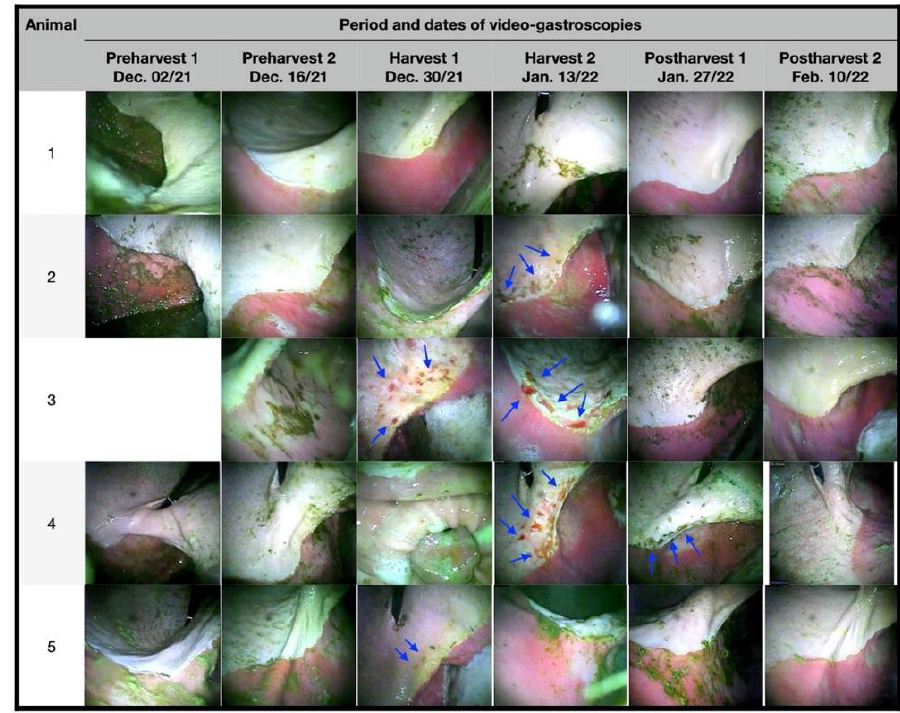
Figure 1. Photographs of video gastroscopies of experimental animals preharvest (1 and 2), harvest (1 and 2), and postharvest (1 and 2) in the region of the lesser curvature, close to the antrum of the pylorus. Note: Image of the 3rd animal was not taken at preharvest 1. Numbers at 1st column are experimental animal s’ numbers . Arrows indicate ulcers and erosions area.